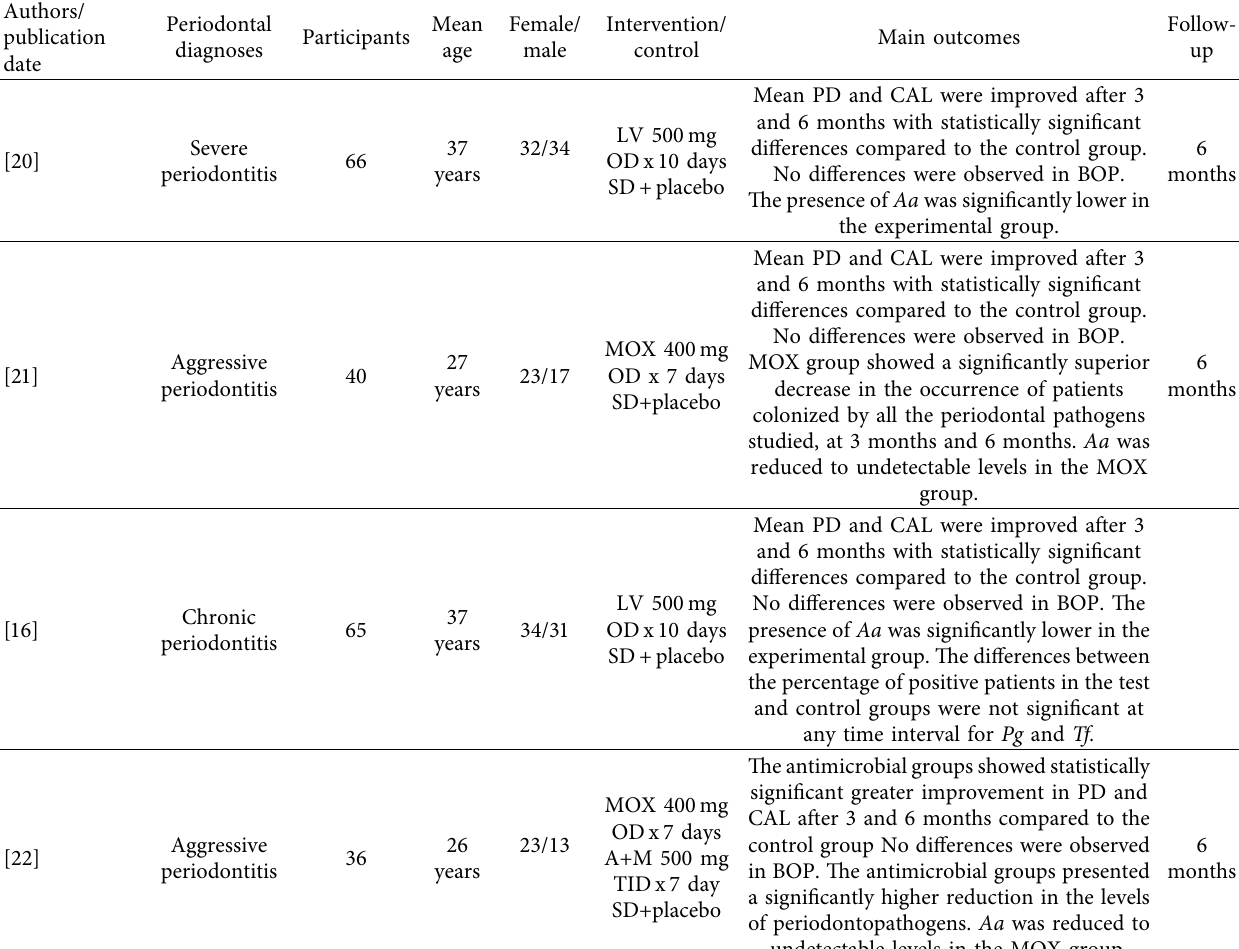
Table 1: Features of the RCTs